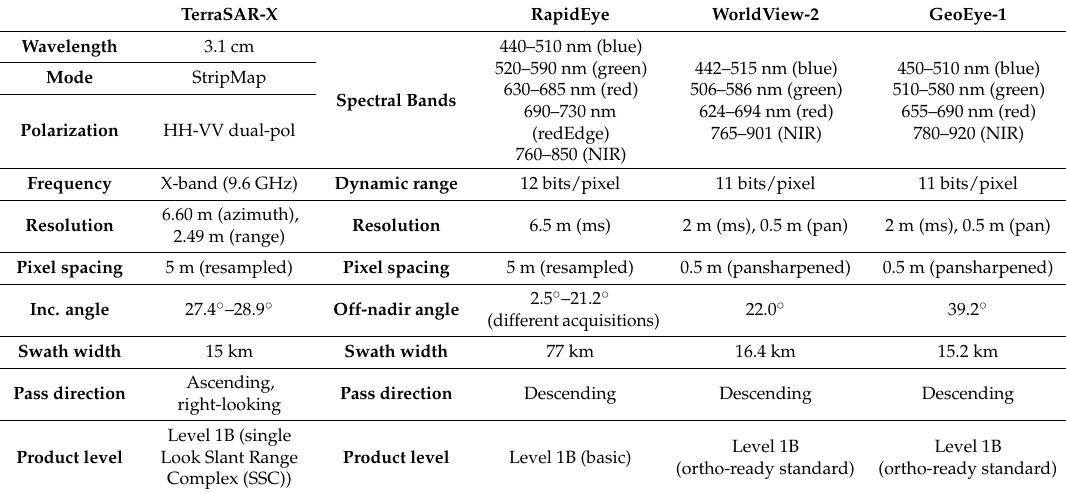
Table 1. Sensor characteristics of the used datasets TerraSAR-X, RapidEye, WorldView-2, and GeoEye-1.